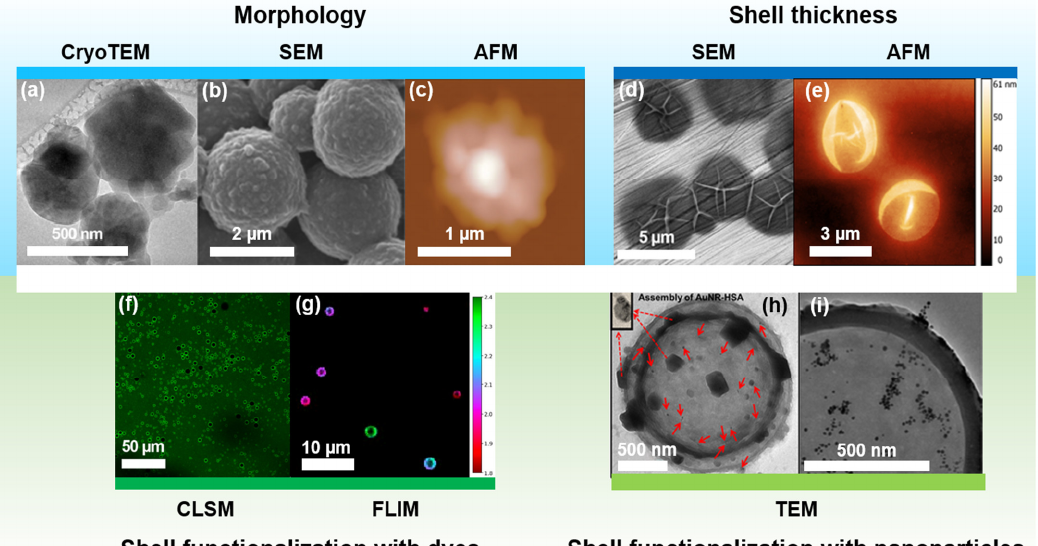
Figure 5. Characterization of MBs with a protein shell: methods to evaluate morphology, shell thick- ness, and functionalization of fabricated agents. Morphology evaluation: ( a ) CryoTEM image of BSA MBs; ( b ) SEM image of modified lysozyme MBs. Adapted with permission from Ref. [89]. Copyright 2013, American Chemical Society; ( c ) AFM image of lysozyme MBs. Adapted with permission from Ref. [133]. Copyright 2008, American Chemical Society; Shell thickness measurements: ( d ) SEM and ( e ) AFM images of BSA MBs were used to evaluate shell thickness; confirmation of shell functionalization with dyes: ( f ) CLSM and ( g ) FLIM images of rhodamine-labeled BSA MBs; Confirmation of shell functionalization with nanoparticles: ( h ) TEM image of gold nanorods (AuNRs) functionalized HSA MBs. Adapted with permission from Ref. [145]. Copyright 2012, SPIE; ( i ) TEM image of gold nanoparticles (AuNPs) functionalized lysozyme MBs. Adapted with permission from Ref. [89]. Copyright 2013, American Chemical Society. Abbreviations: cryoTEM, transition electron cryomicroscopy; SEM, scanning electron microscopy; AFM, atomic force microscopy; CLSM, confocal laser-scanning microscopy; FLIM, fluorescence lifetime imaging microscopy; TEM, transition electron microscopy. Where red arrows indicate single AuNRs and dashed ones point to assemblies of AuNR and